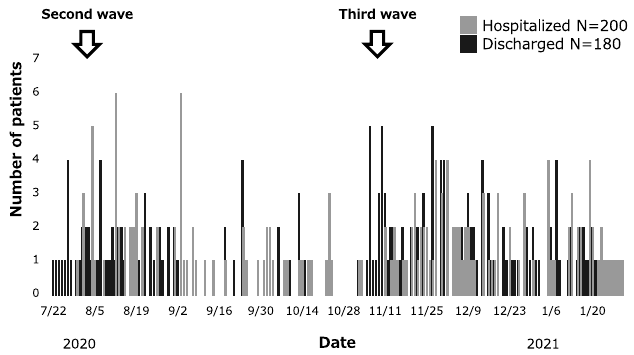
Figure 2 Daily number of patients with COVID-19 hospitalized and discharged. Silver bar is number of hospitalized patients, black bar is number of discharged